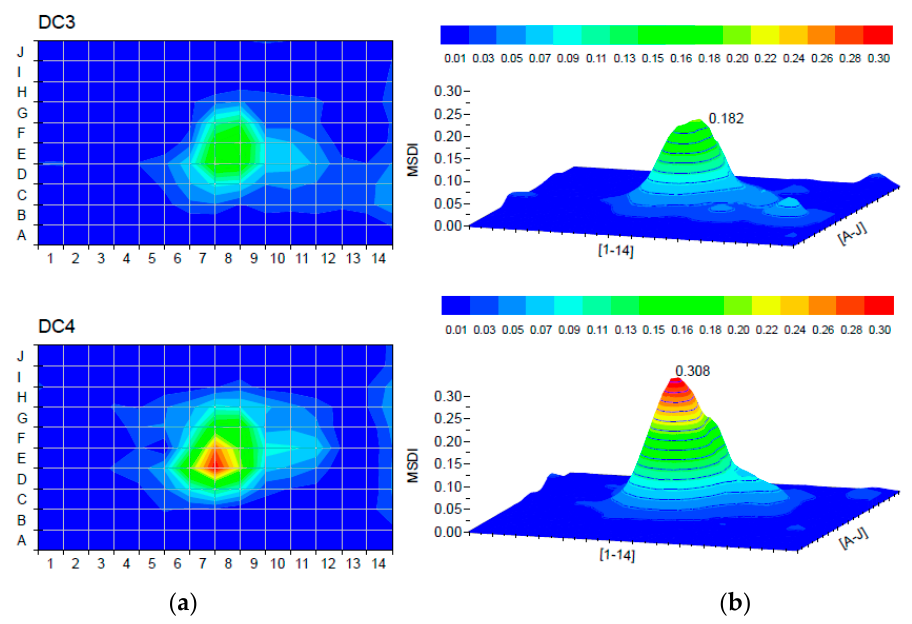
Figure 8. Damage localization for damage cases DC3 and DC4: ( a ) 2D; ( b ) peak values in 3D.